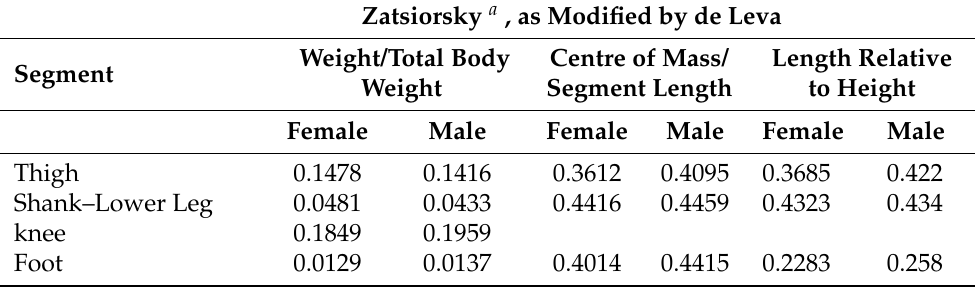
Table 5. Body segment coefficients as calculated for Zatsiorsky